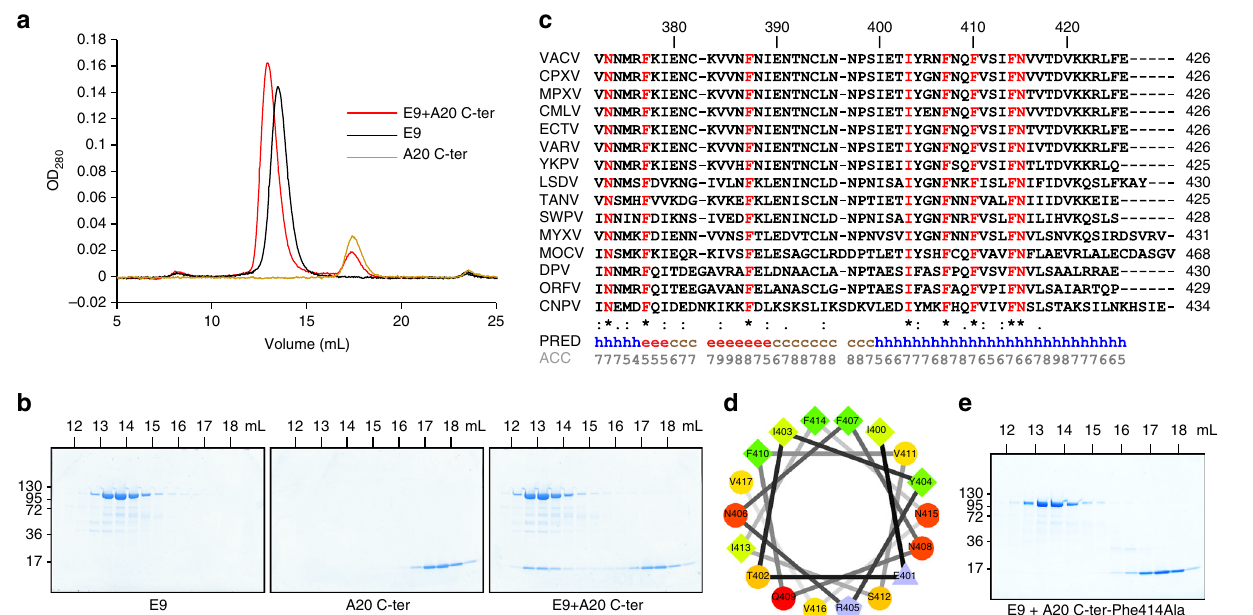
Fig. 2 The C-terminal domain of A20 (A20 C-ter) interacts with VACV E9. a Elution pro fi les from SEC are compared. A20 C-ter and E9 were either loaded separately or mixed together prior to injection onto the column. b SDS-PAGE analysis of the eluted fractions for each run. c Alignment of the last amino acids of A20 using representative viruses from each genus of the Chordopoxvirinae subfamily: VACV , CPXV (cowpox virus), MPXV (monkeypox virus), CMLV (camelpox virus), ECTV (ectromelia virus), VARV (variola virus), YKPV (yokapox virus), LSDV (lumpy skin disease virus), TANV (tanapox virus), SWPV (swinepox virus), MYXV (myxoma virus), MOCV (molluscum contagiosum virus), DPV (deerpox virus), ORFV (ORF virus), CNPV (canarypox virus). Conserved residues are in red. The predicted secondary structure using MLRC 66 and its reliability on a 0 – 9 scale are shown at the bottom of the alignment (ACC). d Helical wheel projection with residues of A20 predicted to fold as an α -helix (aa 400 – 417). Hydrophilic residues are presented as circles, hydrophobic residues as diamonds, charged residues as triangles and pentagons. e A point mutation in A20 C-ter abrogates binding to E9. A20 C-ter- Phe414Ala was incubated with WT E9 before injection onto SEC. The eluted fractions were analyzed as in